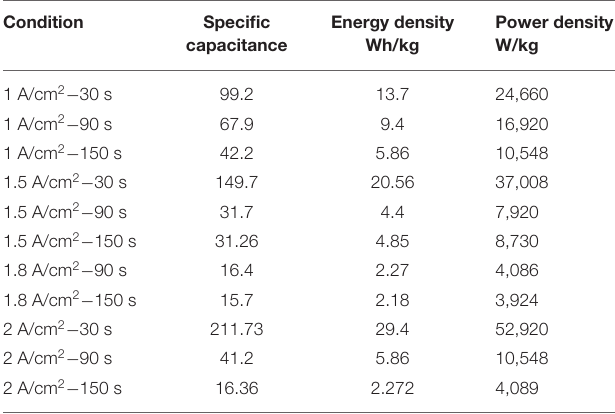
TABLE 6 | Evaluation of Ni–Cu deposits as electrodes for supercapacitor. Condition Specific Energy density Power density capacitance Wh/kg